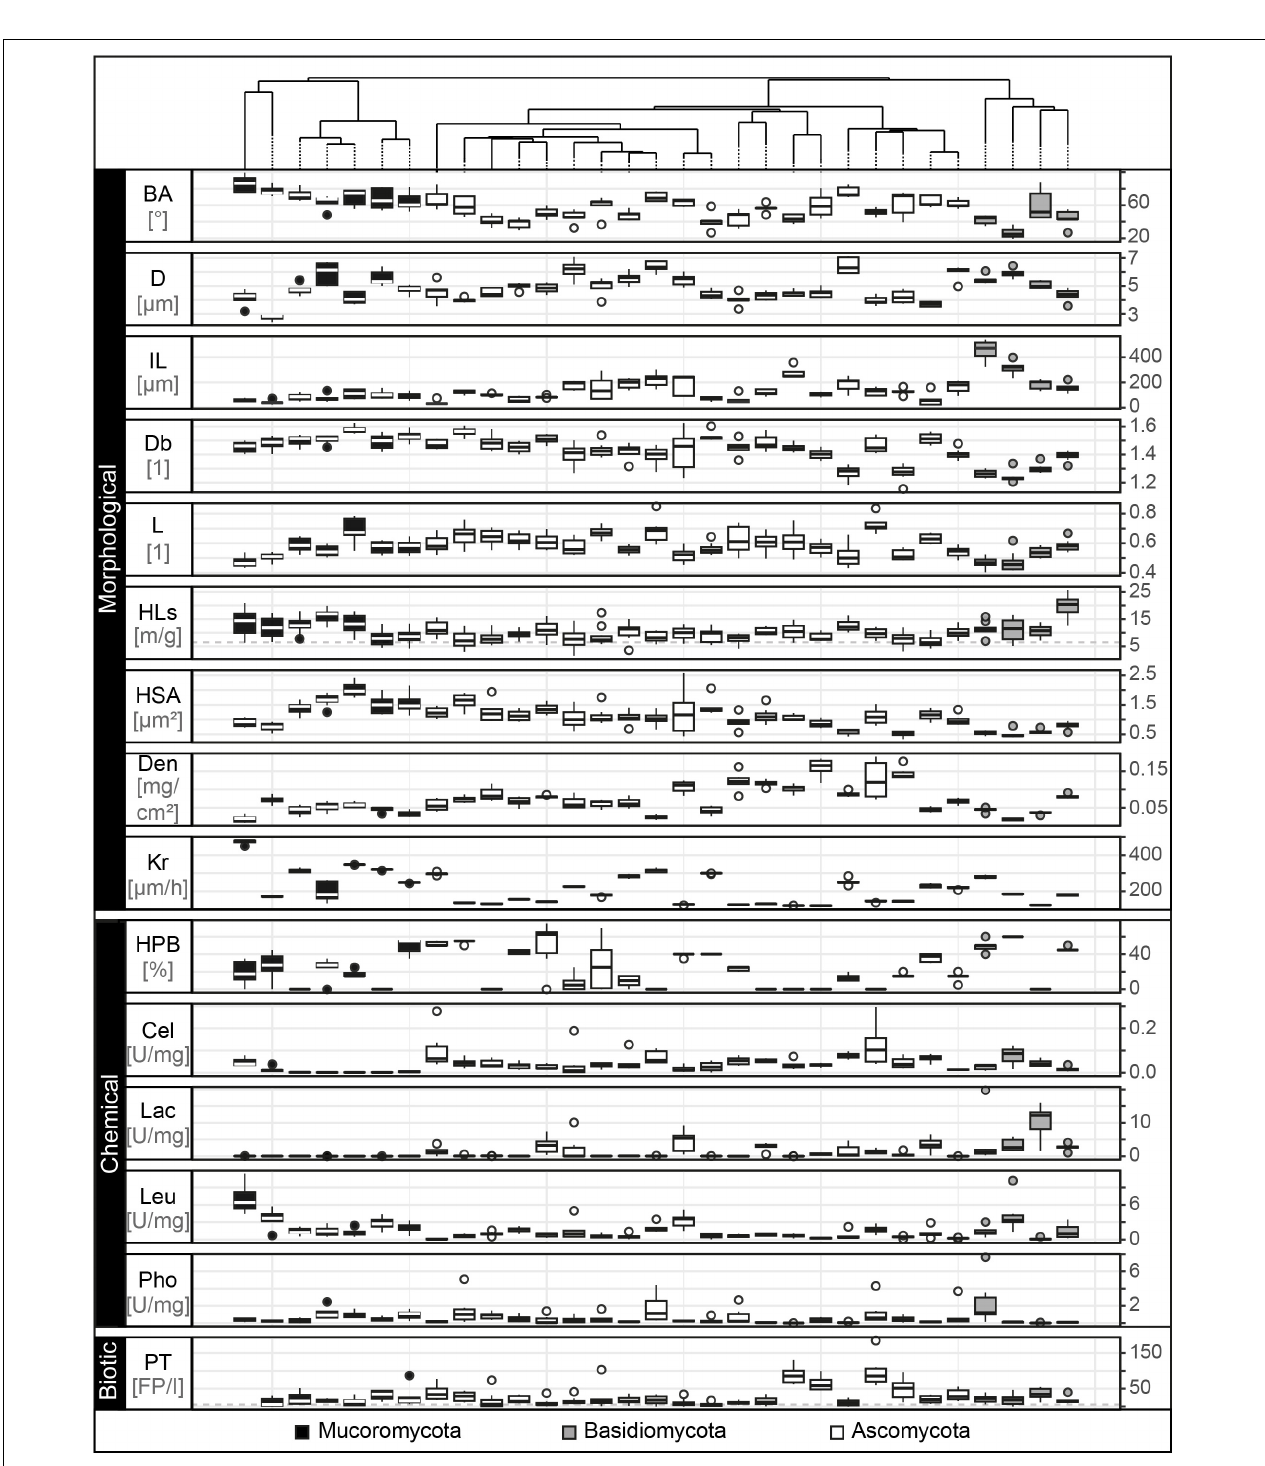
FIGURE 3 | Trait distributions. Tukey boxplots of the 15 trait variables comprising morphological, chemical and biotic fungal features. Here, we present data on branching angle (BA with n = 5 in ◦ ), hyphal diameter (D with n = 5 in µ m), internodal length (IL with n = 5 in µ m), box counting dimension (Db with n = 8, unitless), lacunarity (L with n = 8, unitless), hyphal length in soil (HLs with n = 10 in m/g), hyphal surface area (HSA with n = 8 in µ m 2 ), biomass density (Den with n = 6 in mg × cm - 2 ), radial colony extension rate (Kr with n = 5 in µ m × h - 1 ), hydrophobicity of fungal surfaces (HPB with n = 6 in% of ethanol molarity), cellobiohydrolase (Cel), laccase (Lac), leucine aminopeptidase (Leu), and acid phosphatase (Pho) activity (each with n = 5 in unit × g - 1 dry mass) and palatability (PT with n = 8 in no. of fecal pellets per collembolan individual). The boxplots represent 25th and 75th percentile, median and outlying points. Information about phylum affiliation is color-coded (black: Mucoromycota, gray: Basidiomycota, white: Ascomycota). The gray dashed line for the trait hyphal length in soil represents mean of corresponding trait controls. The trait database is available in Supplementary Table S6 .